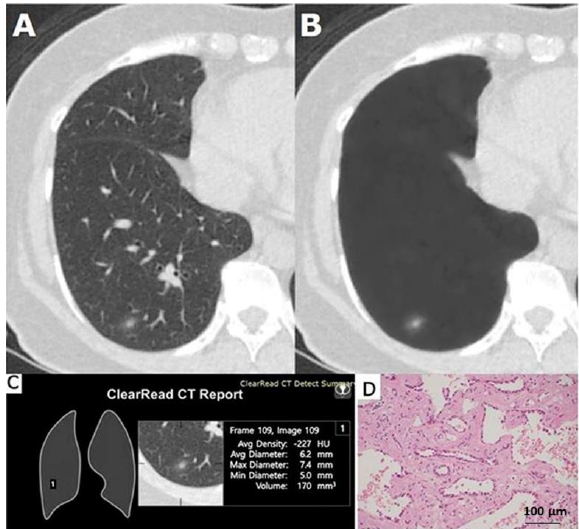
Figure 1. A 59-year-old female was found to have a 6.2 mm part-solid nodule in the right lower lobe (RLL) which was proven to be an acinar predominant adenocarcinoma. ( A ) Low-dose computed tomogram. ( B ) Its vessel-suppressed image showed a 6.2 mm part-solid nodule left in RLL. ( C ) The vessel-suppressed and computer-aided detection artificial intelligence analyzer indicated that the nodule was actionable. ( D ) Microphotograph of the specimen showed acinar predominant adenocarcinoma (hematoxylin and eosin stain, × 200).